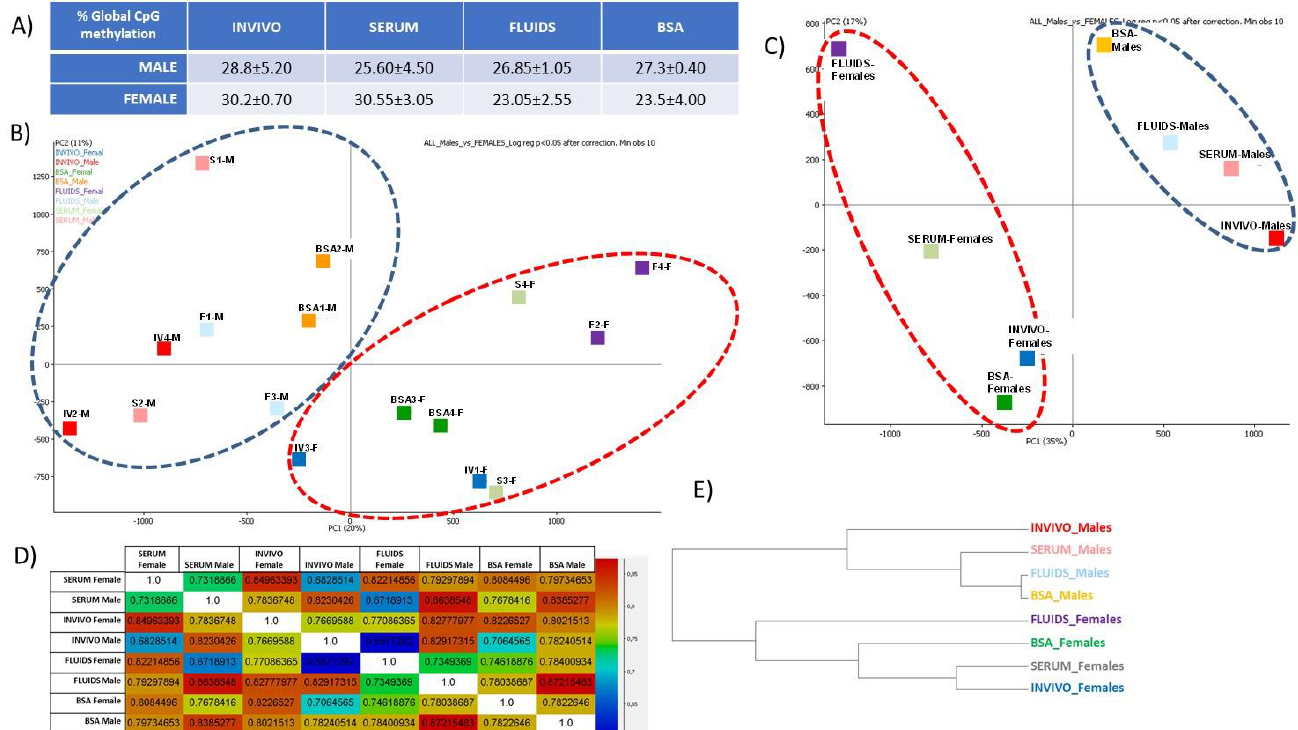
Figure 5. DNA methylation in female versus male bovine in vivo- or in vitro-derived blastocysts. ( A ) Global CpG methylation values for sexed blastocyst in each group. ( B ) PCA for individual blastocysts. F and M suffixes in the blastocyst ID label the sex (F: female; M: male). ( C ) PCA for samples split by culture group and sex (sub-groups). ( D ) Correlation coefficient between each subgroup. ( E ) Hierarchical clustering by subgroups.